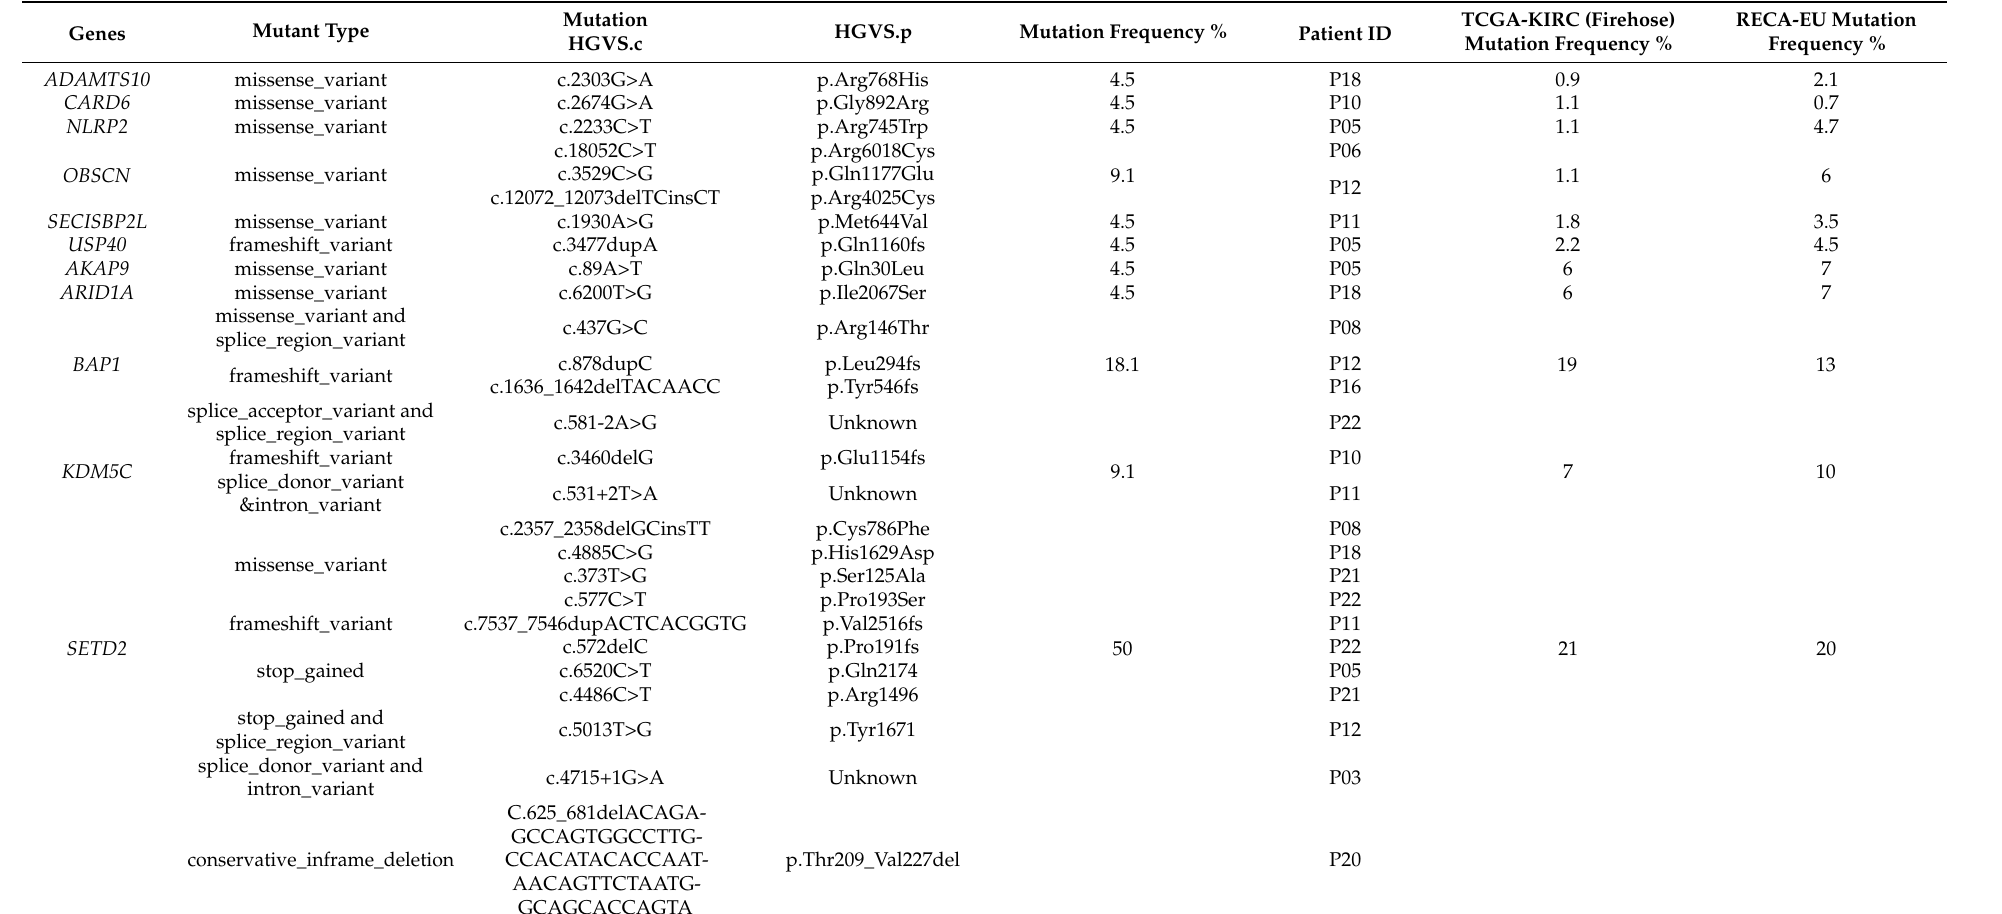
Table 5. Types and frequencies of 11 clinically significant mutated genes found in 22 Korean patients with clear cell renal cell